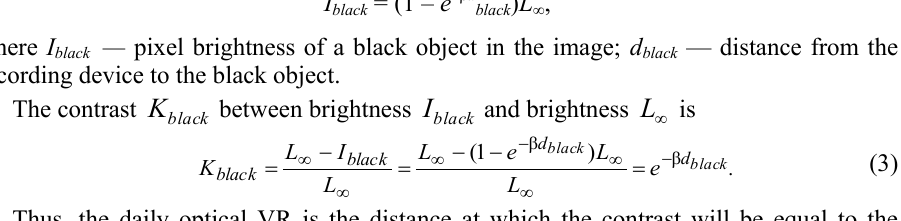
I = (1 – e –β d ) L black black ∞